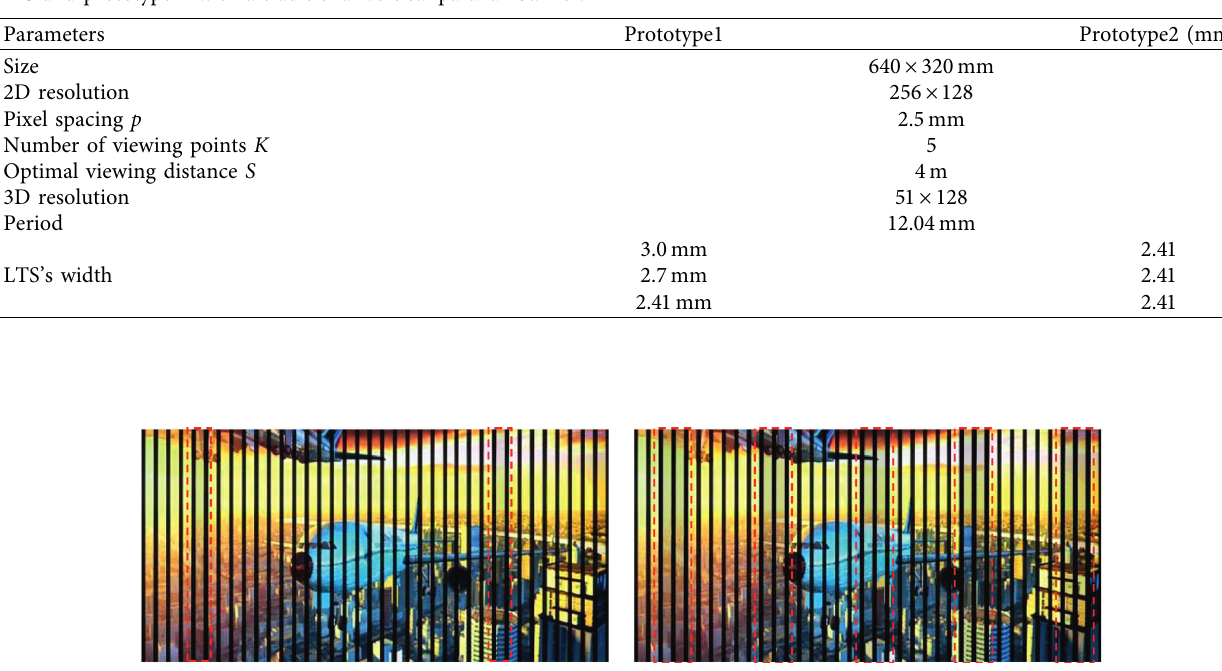
Table 1: Specifications and parameters of the two prototypes, prototype 1 with a misplaced parallax barrier with nonuniform width of the LTS and prototype 2 with a traditional vertical parallax barrier.